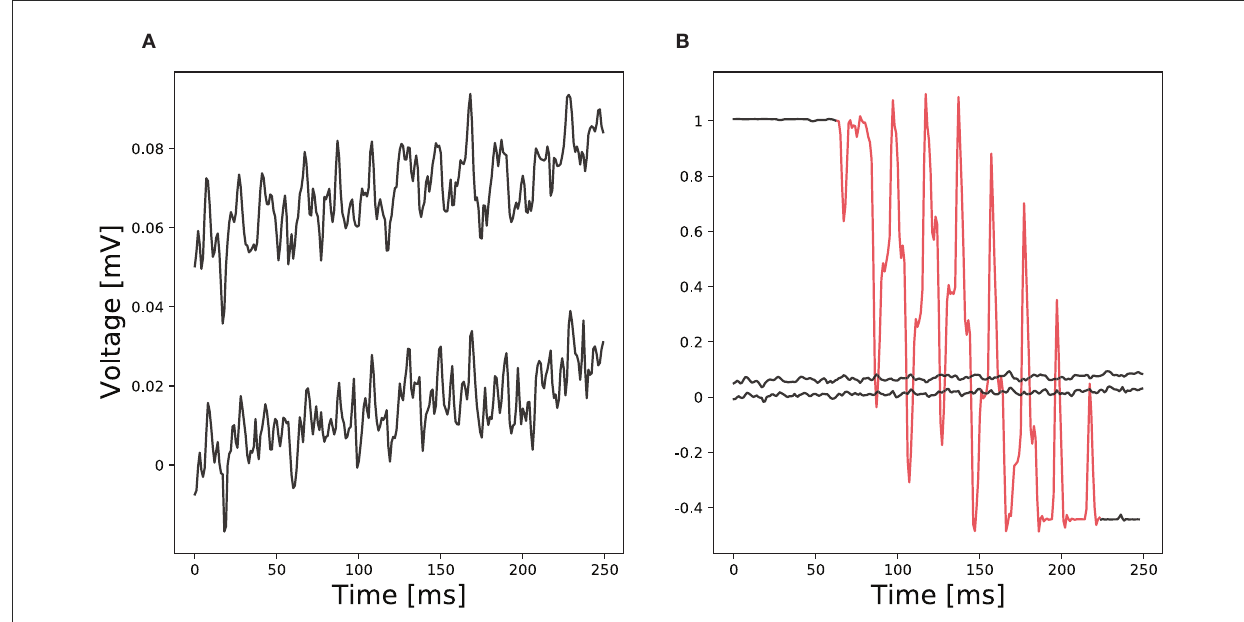
FIGURE1 Comparison of two EEG examples: (A) Ordinary EEG recordings from two different electrodes and (B) a red marked channel with transient interferences compared to ordinary EEG recordings.